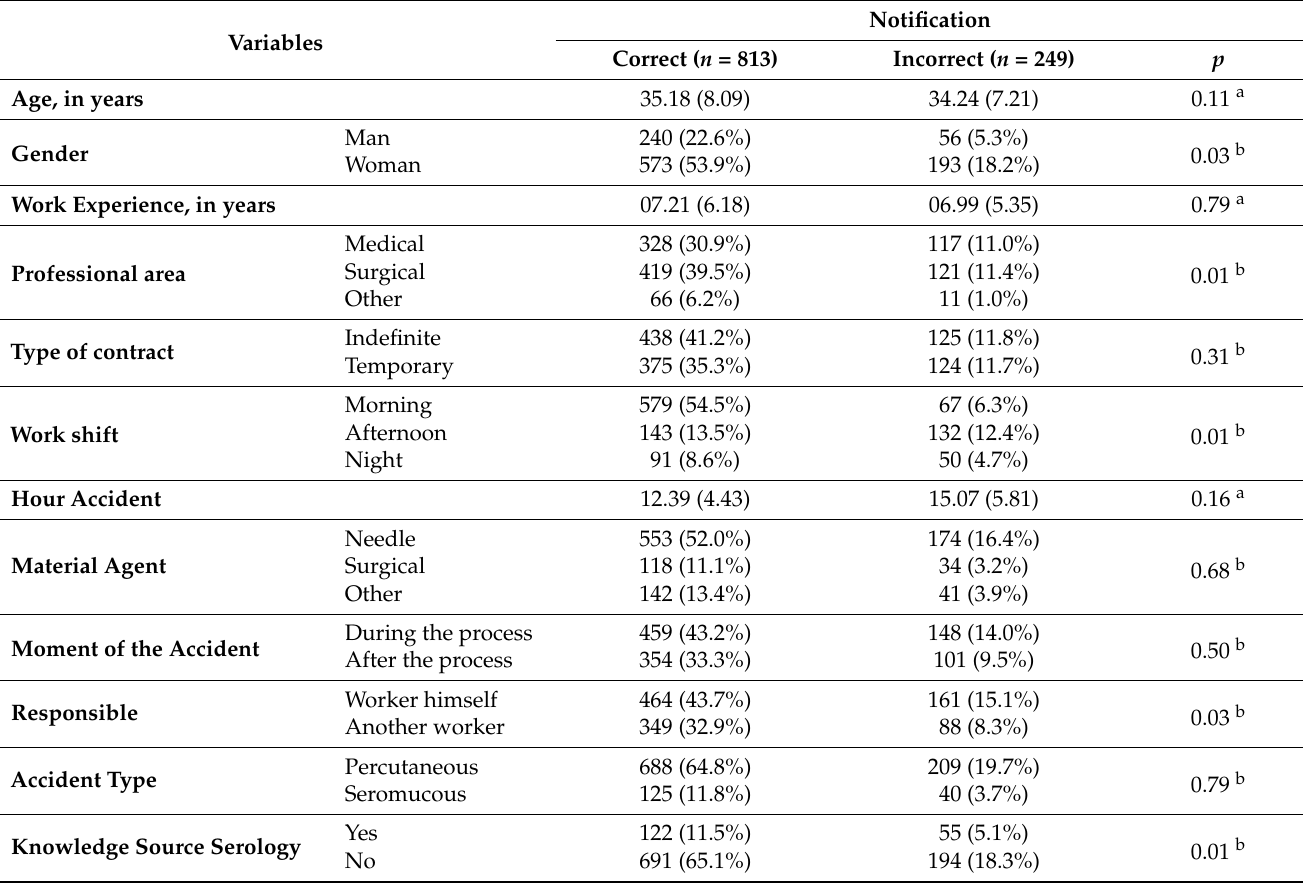
Table 2. Association between notification and possible risk factors.